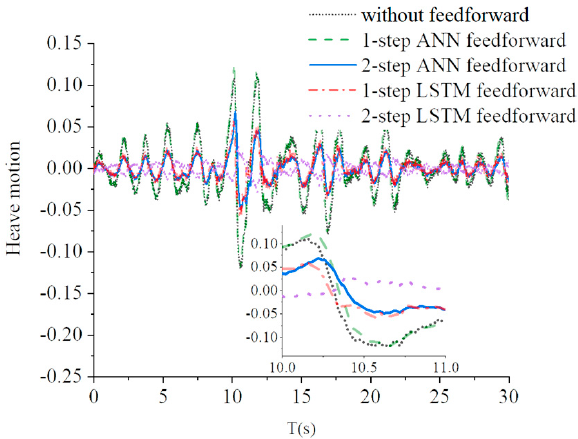
Figure 15. Compensated heave motions of the payload of irregular structure motion.